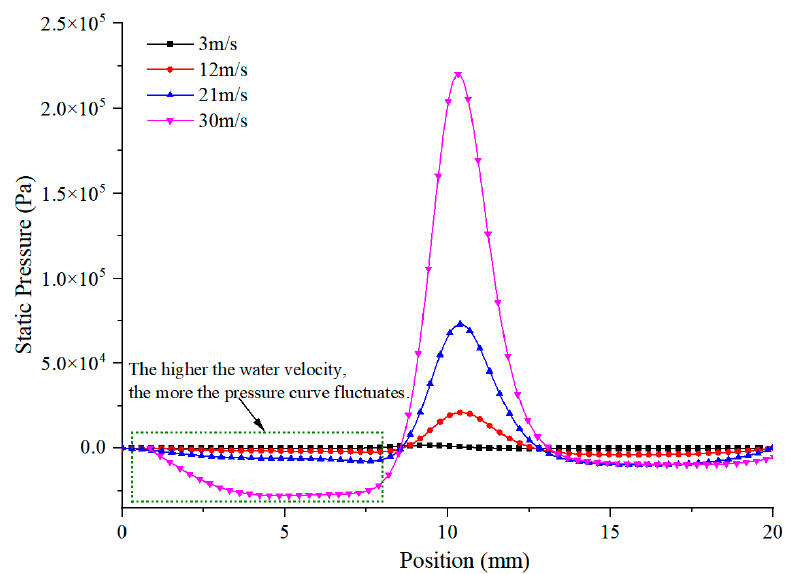
Figure 7. Impact force generated by different water velocities hitting the workpiece.